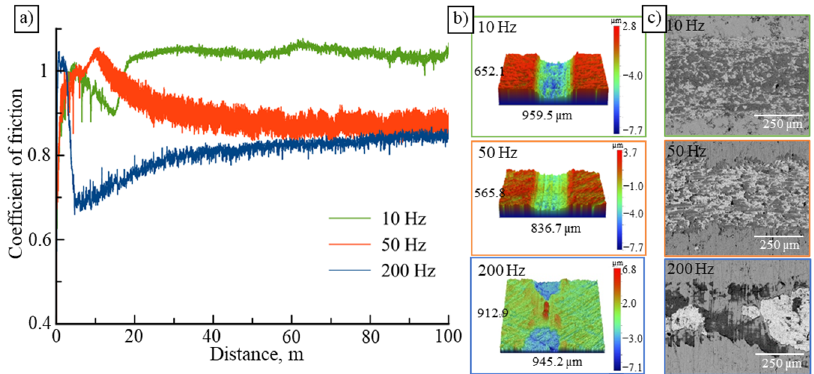
Figure 3. The coefficient of friction ( a ) as a function of distance, the 3D profiles ( b ) and SEM images of tribocontact zone ( c ) of the Mo ‐ Zr ‐ Si ‐ B coatings deposited at 10, 50, and 200 Hz.